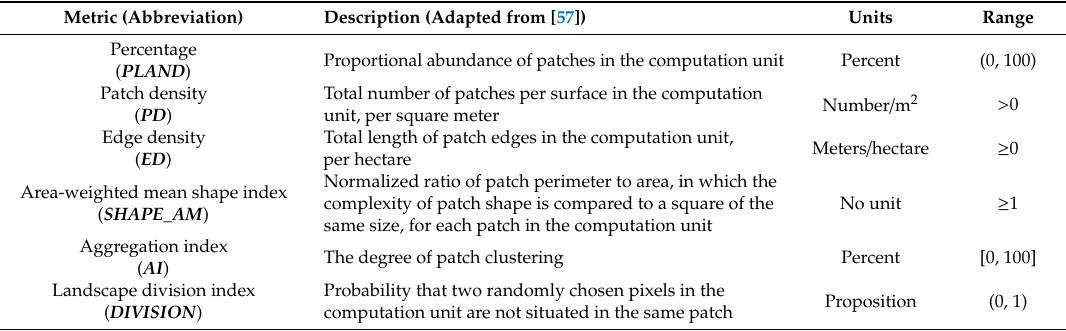
Table 4. Landscape metrics used in this